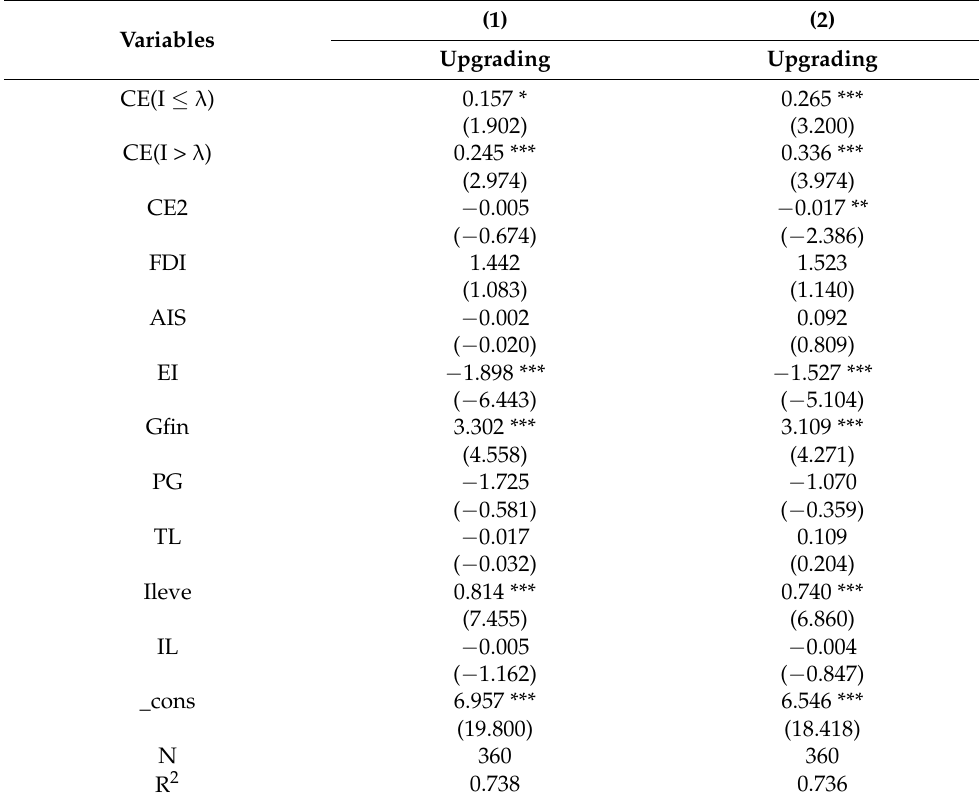
Table 6. Threshold effects of urbanization and marketization on the relationship between carbon intensity and green